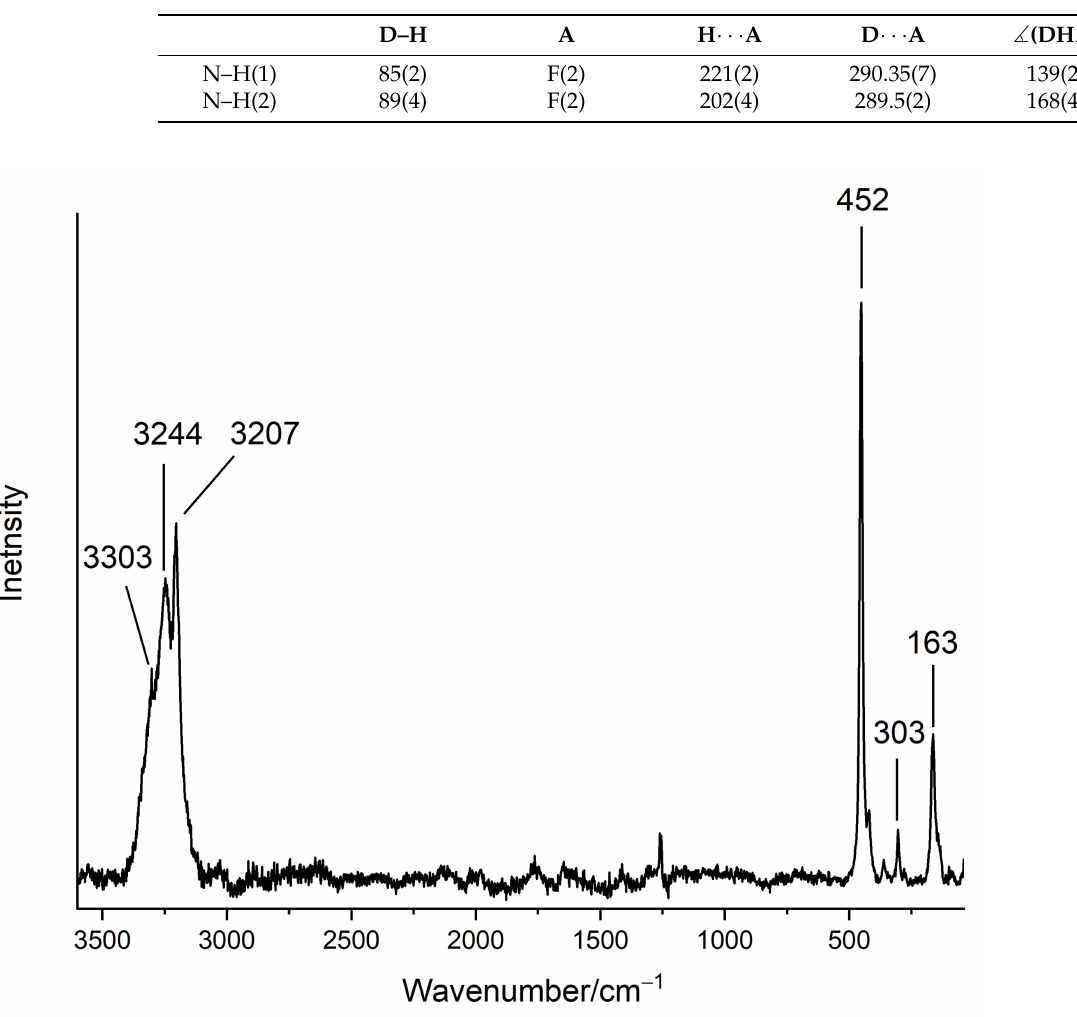
Table 5. Interatomic distances (in pm) and angles (in deg.) of the hydrogen bonds in InAlF 6 (NH 3 ) 2 .